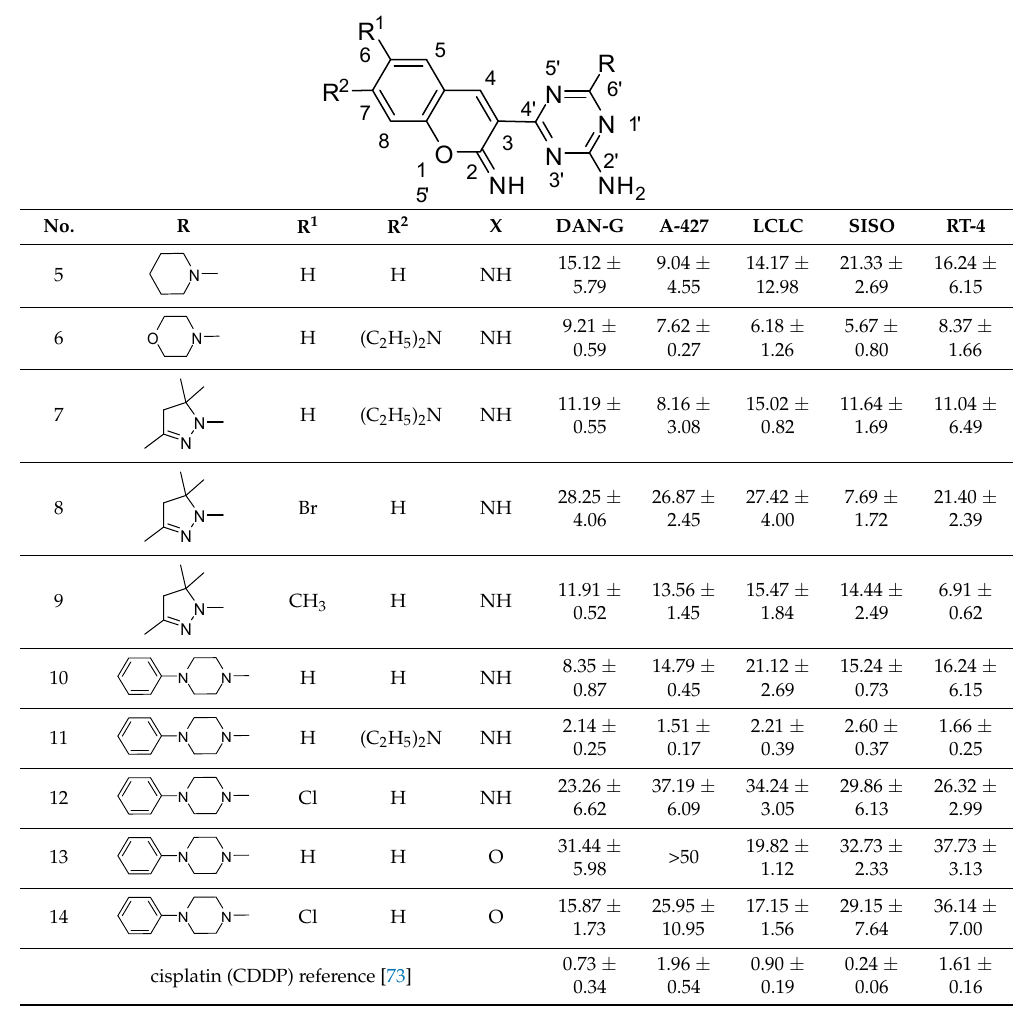
Table 1. Cytotoxic activity of 2-imino-2 H -chromen-3-yl-1,3,5-triazines 5 – 12 and 2 H -chromen-3-yl-